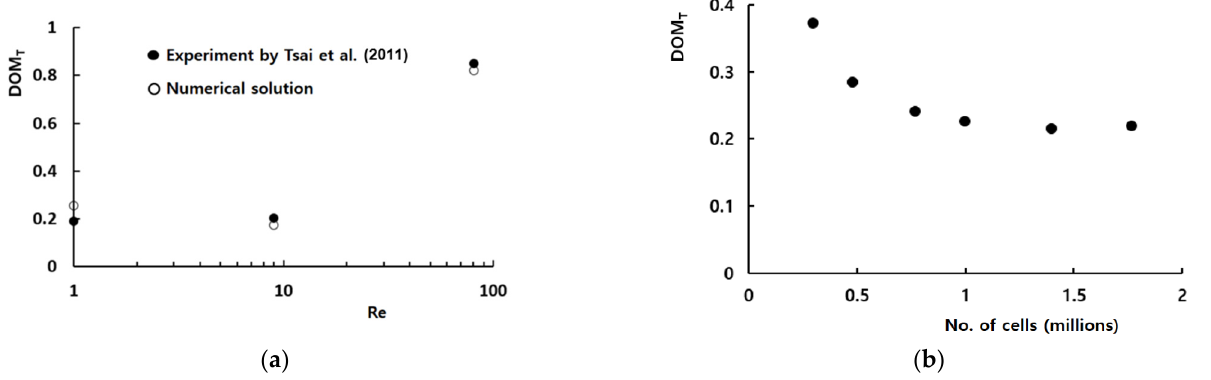
Figure 4. Validation of the numerical solution: ( a ) DOM vs. Re and ( b ) Grid dependence of the numerical solution [19].